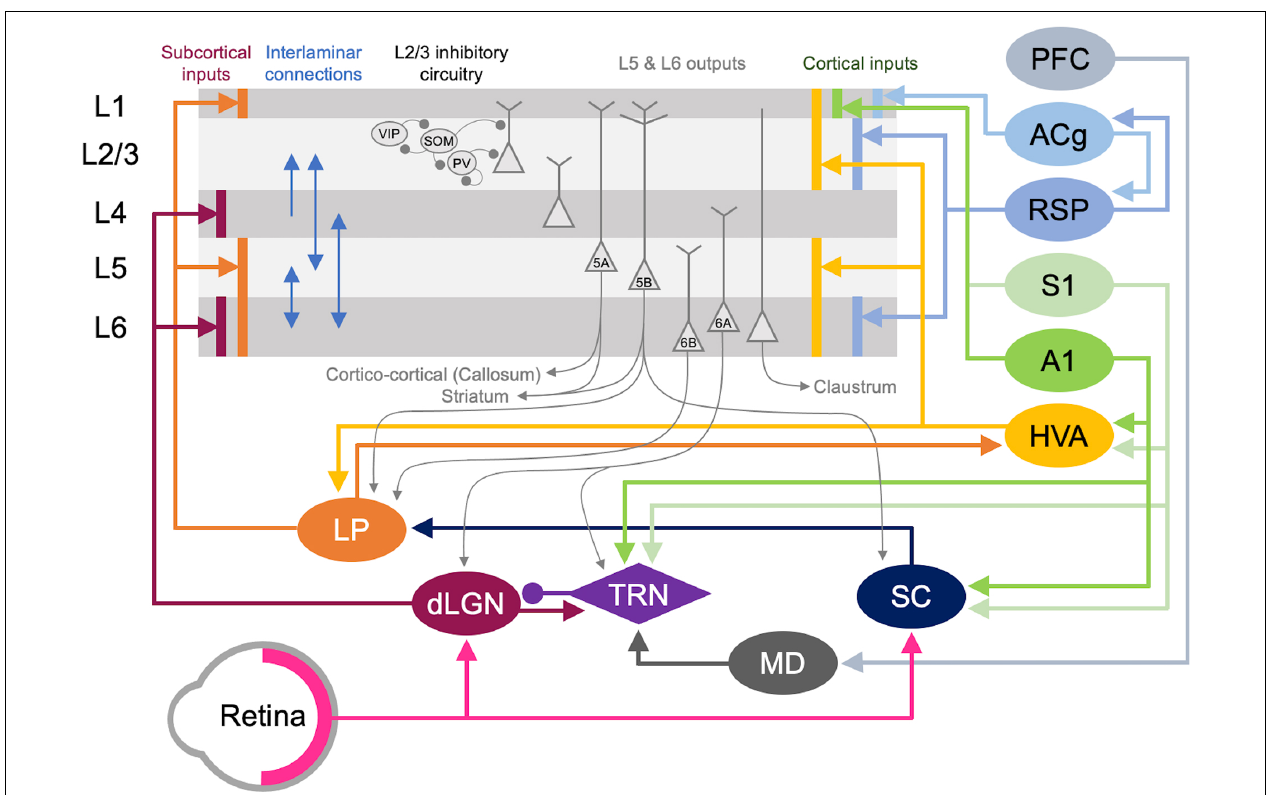
FIGURE 5 | Cortical and subcortical circuits for multisensory influence on V1. The laminar profile of subcortical inputs from dLGN and LP to V1 is shown on the left. Major interlaminar excitatory connections are shown next in blue arrows followed by the inhibitory local circuit in L2/3. Next, the major outputs of L5 and L6 neurons are shown. At the rightmost side, the origins and laminar profiles of cortical inputs to V1 are shown. Subcortical structures are shown below V1 and cortical structures are listed on the right side. Arrows ( → ) depict excitatory inputs and inputs ending in a round circle (— • ) show inhibitory connections. The extent of the spread of inputs to V1 that span different laminae are depicted as vertical bars. V1 L2/3 and L5A neurons form reciprocal connections with HVA neurons (Kim et al., 2015; Glickfeld and Olsen, 2017), which is omitted in the figure for clarity. Direct cortico-cortical connections that can provide multisensory information to V1 originate from HVA, A1, S1, RSP, and ACg. In addition, as depicted in the figure many of the subcortical and cortical structures form cortico-thalamo-cortical loops that can provide multisensory influence on V1: for example, HVA–LP–V1, PFC–MD–TRN–dLGN–V1, S1/A1–TRN–dLGN–V1, and